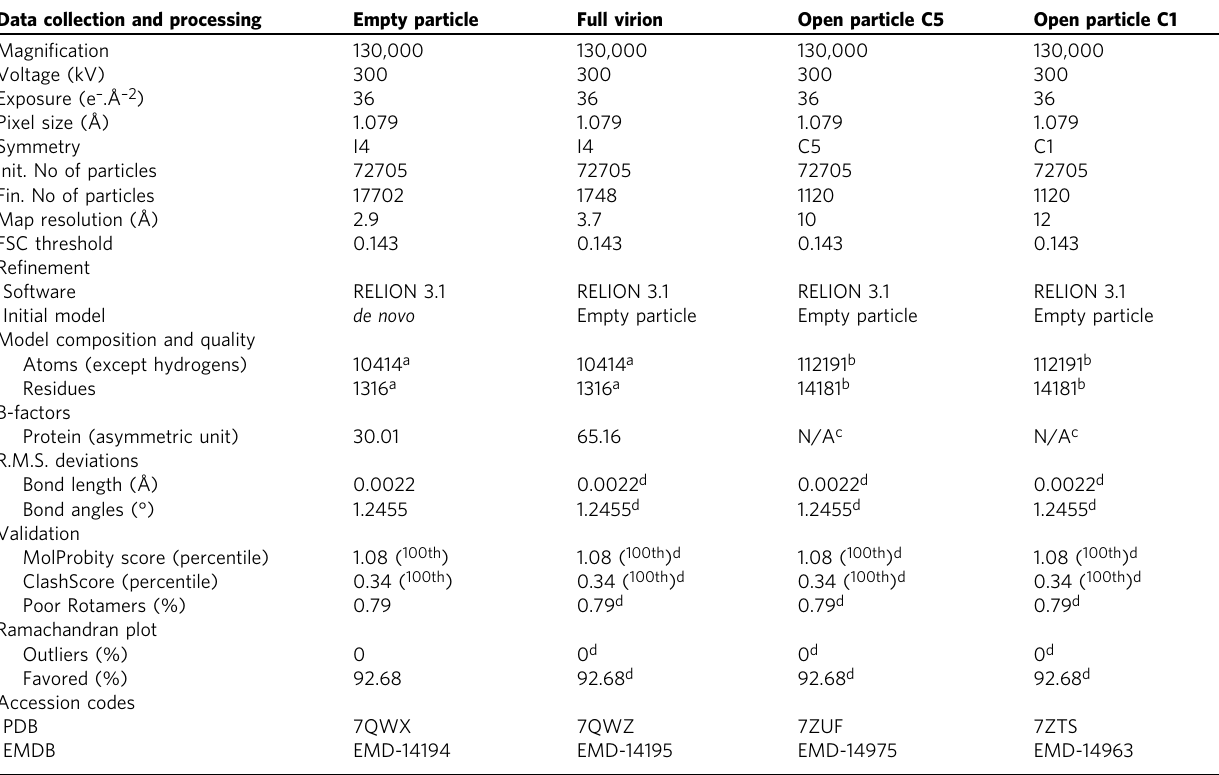
Table 1 Cryo-EM structure quality indicators. Data collection and processing